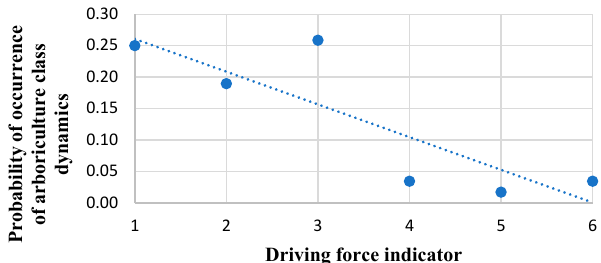
Figure 4. Relationship between probability of occurrence for driving forces of arboriculture culture dynamics as perceived by households.